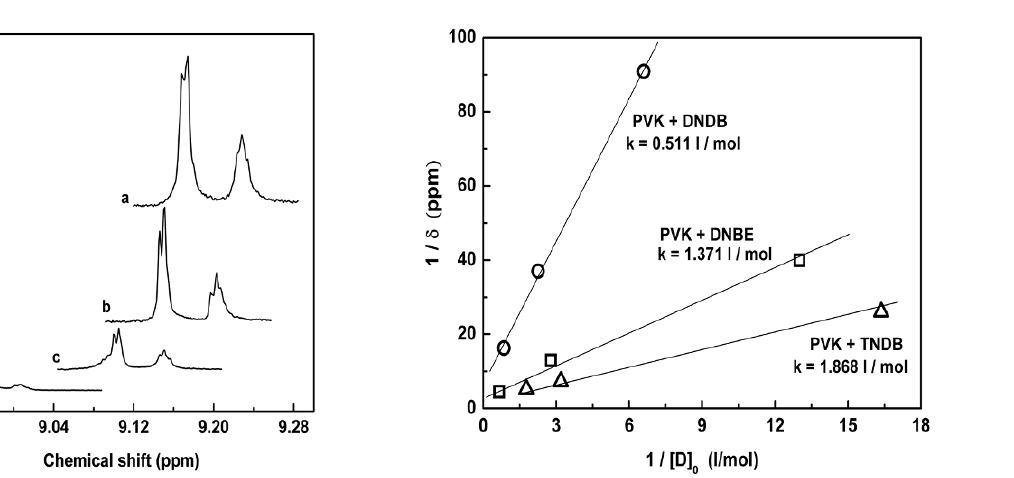
Figure 8. Benesi-Hildebrand plots from 1 H-NMR data.